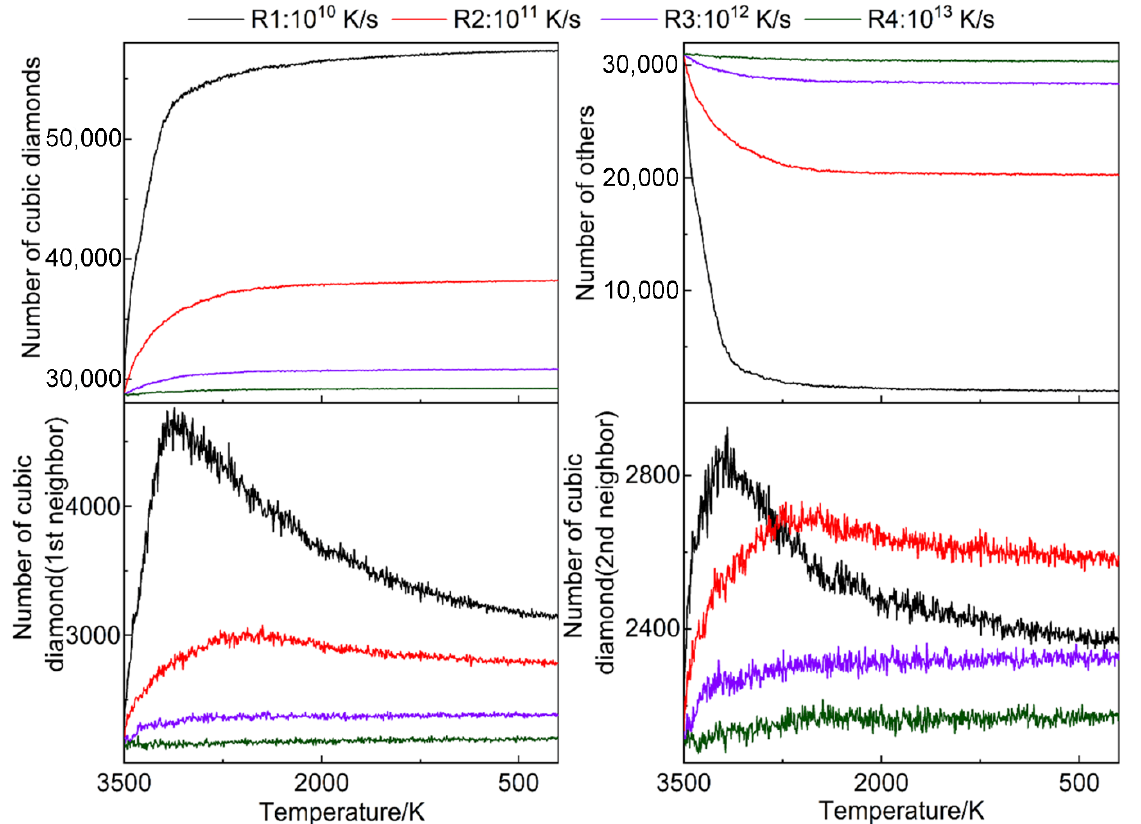
Figure 8. Statistical parameters for different cooling rates.